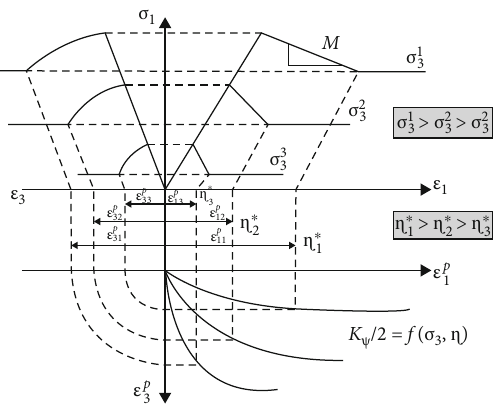
Figure 6: Geometrical diagram for estimating the value of η ∗ [8,